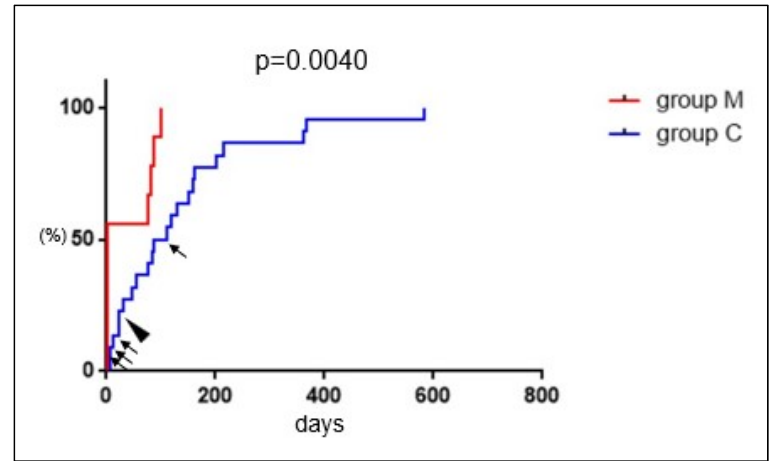
Figure 7. The cumulative rate of RPOC resolution. The horizontal and vertical axes indicate the duration from delivery to resolution (days) and the cumulative incidence rate (%), respectively. Arrows and arrow head indicate the timing of MROP and TCR, respectively. RPOC: retained products of conception; MROP: manual removal of the placenta; TCR: transcervical resection.